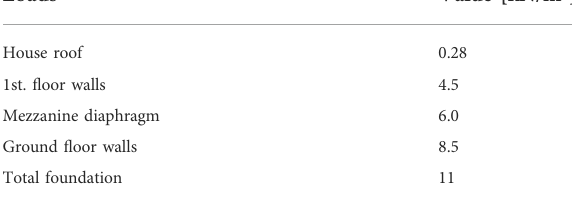
TABLE 2 Accumulated loads in the structure.